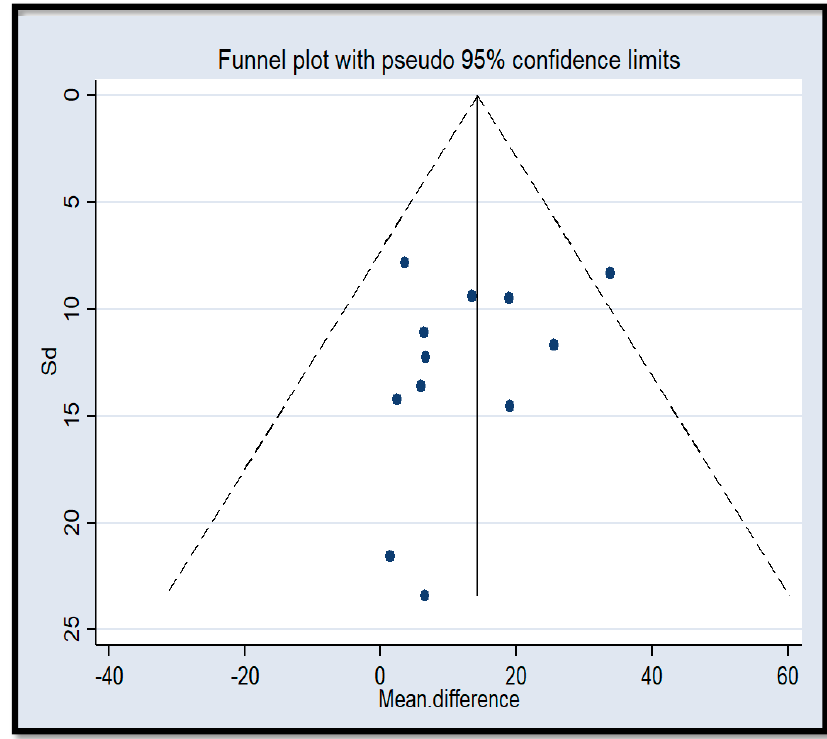
Figure 7. Funnel plot of standard error to assess publication bias for intervention outcomes, Sd: standard error.